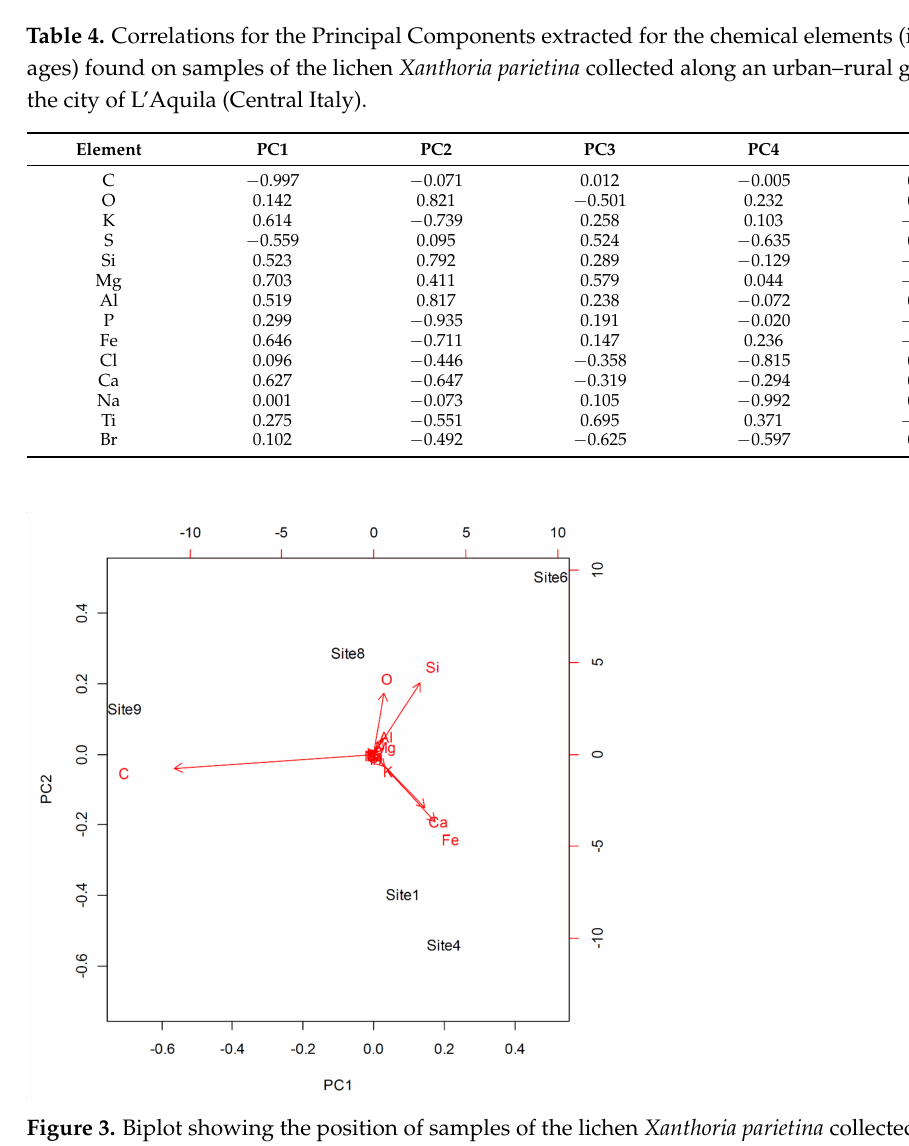
Figure 3. Biplot showing the position of samples of the lichen Xanthoria parietina collected along an urban–rural gradient in the city of L’Aquila (Central Italy) and analysed for the presence of chemical elements according to the results of Principal Components Analysis. The biplot shows the position of each sample in the space defined by the first two Principal Components (93.4% of variance). Arrows indicate the correlations between the Principal Components and element